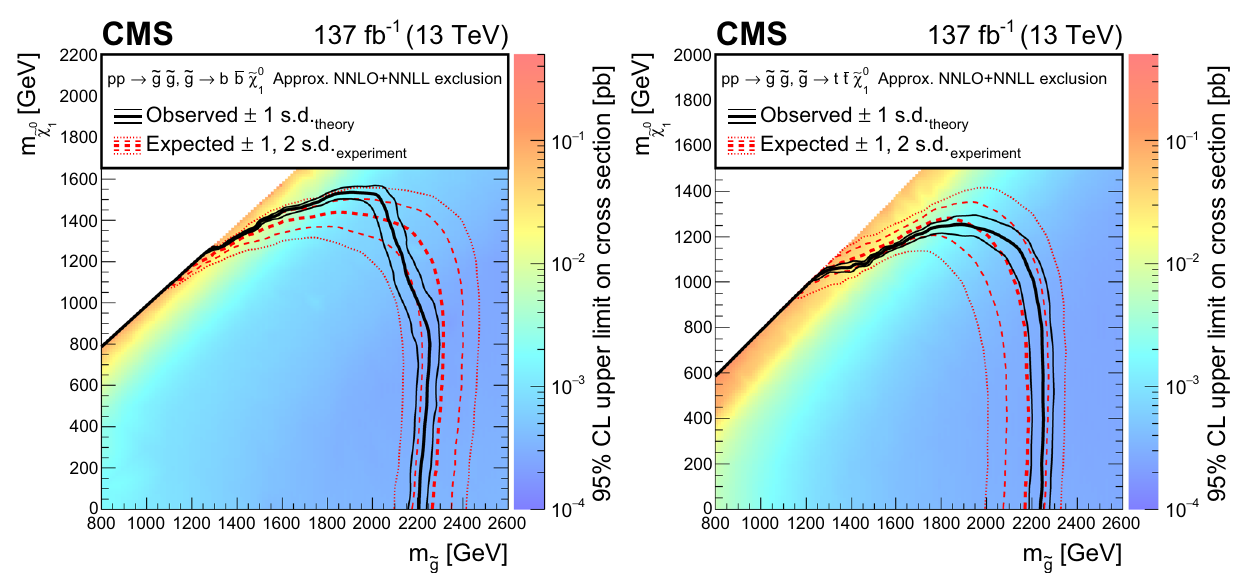
Fig. 12 Exclusion limits at 95% CL for direct gluino pair production where the gluinos decay to (left) bottom quarks and (right) top quarks. The area enclosed by the thick black curve represents the observed exclusion region, while the dashed red lines indicate the expected lim- its and their ± 1 and ± 2 standard deviation (s.d.) ranges. The thin